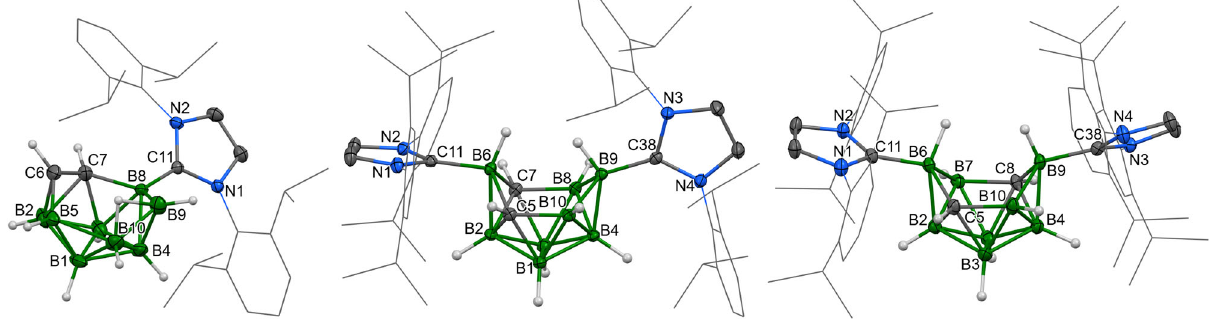
Fig. 2 The molecular structures of o -1 (left), m -2 (centre) and p -2 (right). ORTEP-type plots, 40% probability level. The 2,6-diisopropylphenyl groups are displayed as wireframes for